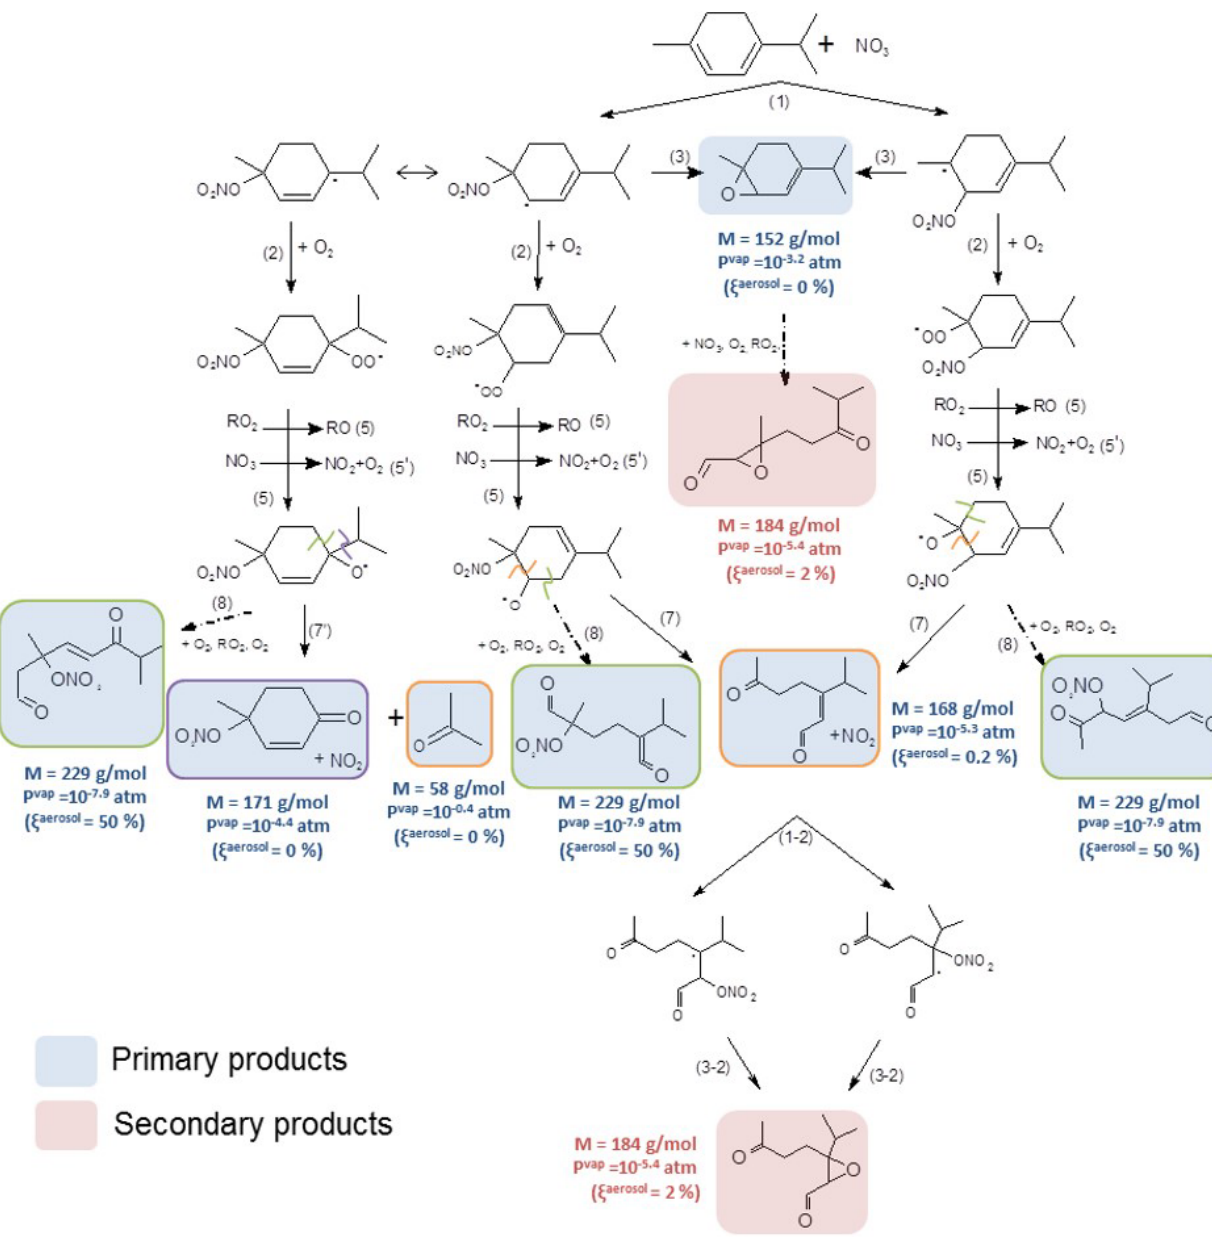
Figure 8. Proposed mechanism for α -terpinene. First-generation products are in blue, and second-generation ones are in red. Alkoxy frag- mentation products are framed according the location of the fragmentation. Molecular weight, vapor pressures and the gas–particle partition are shown next to the molecules. The reaction of the primary epoxide product is shown in the purple